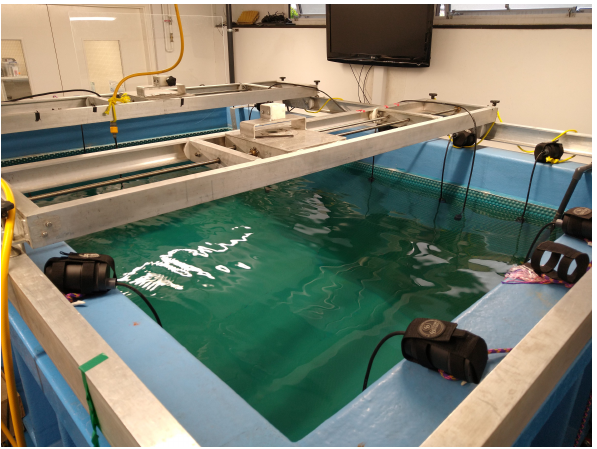
Figure 19. Sensor Nodes positioned around the edge of the anechoic test tank in SEA Lab at Newcastle University. Extensive development and testing of network protocols over long duration runs in the tank environment allowed issues to be resolved prior to sea